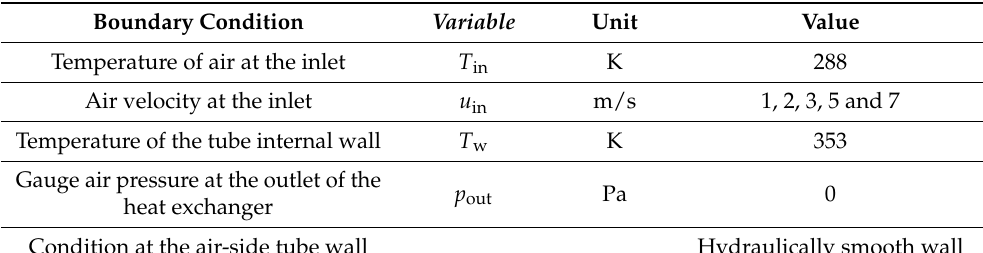
Table 2. Boundary